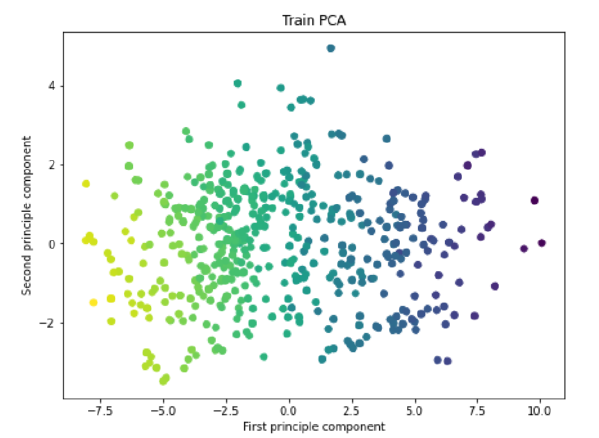
Figure 6. Train PCA